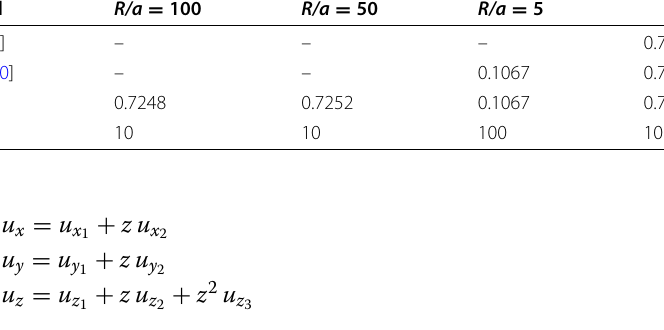
Table 6 0/90/0/90, u z (z = 0) = 100u z E T h 3 /( p z a 4 ) Model R/a =